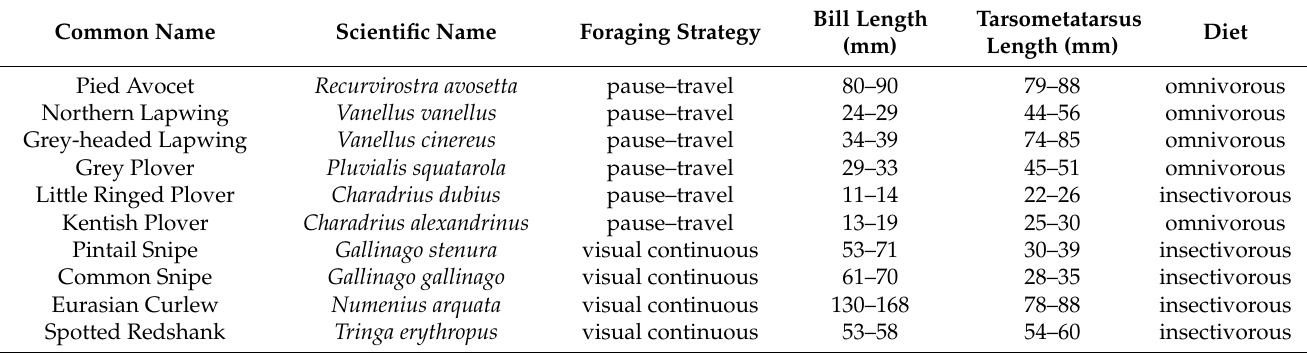
Table A1. Ecological characteristics for different species of